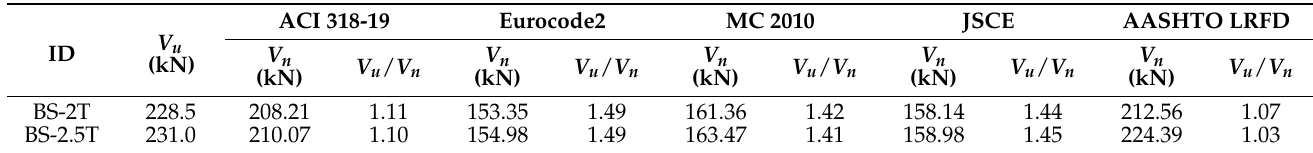
Table 6. Evaluation of test results through code